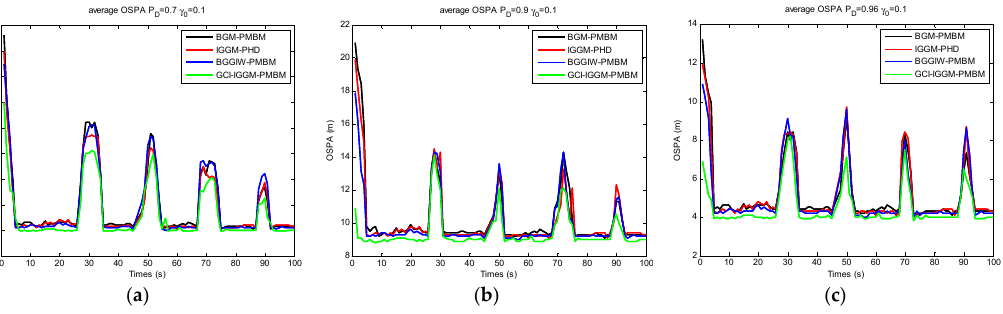
Figure 4. OSPA comparisons of GCI–IGGM–PMBM (our proposed scheme) with other multitarget tracking schemes: ( a ) p D = 0.7; ( b ) p D = 0.9; ( c ) p D = 0.96.